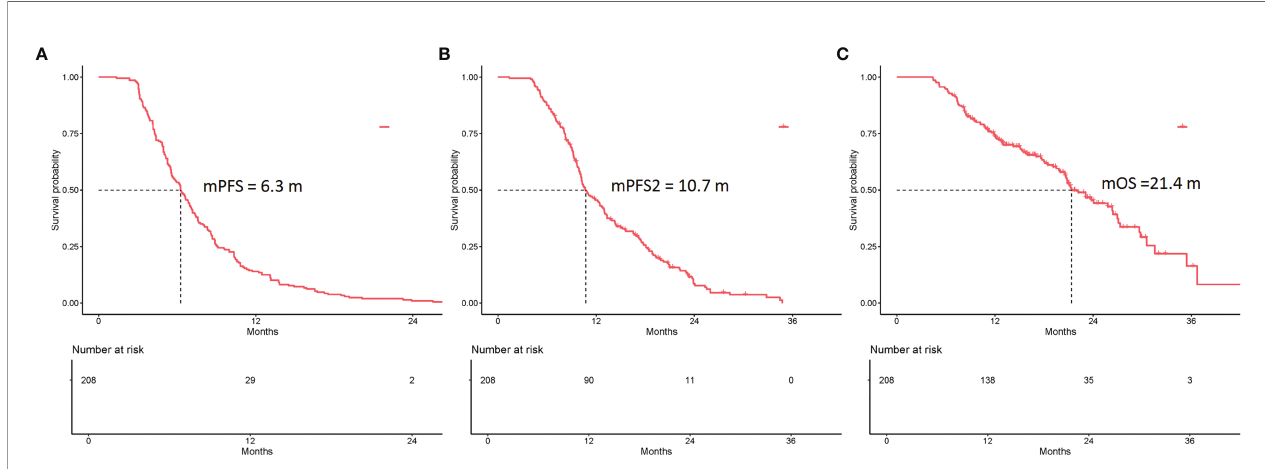
FIGURE 1 | Kaplan-Meier curves of the PFS, PFS2, and overall survival (OS) of all eligible patients (N = 208). (A) The mPFS was 6.3 months (95% CI 5.6 – 7.0 months). (B) The mPFS2 was 10.7 months (95% CI 10.1 – 12.7 months). (C) The mOS was 21.4 months (95% CI 20.6 – 26.4 months).